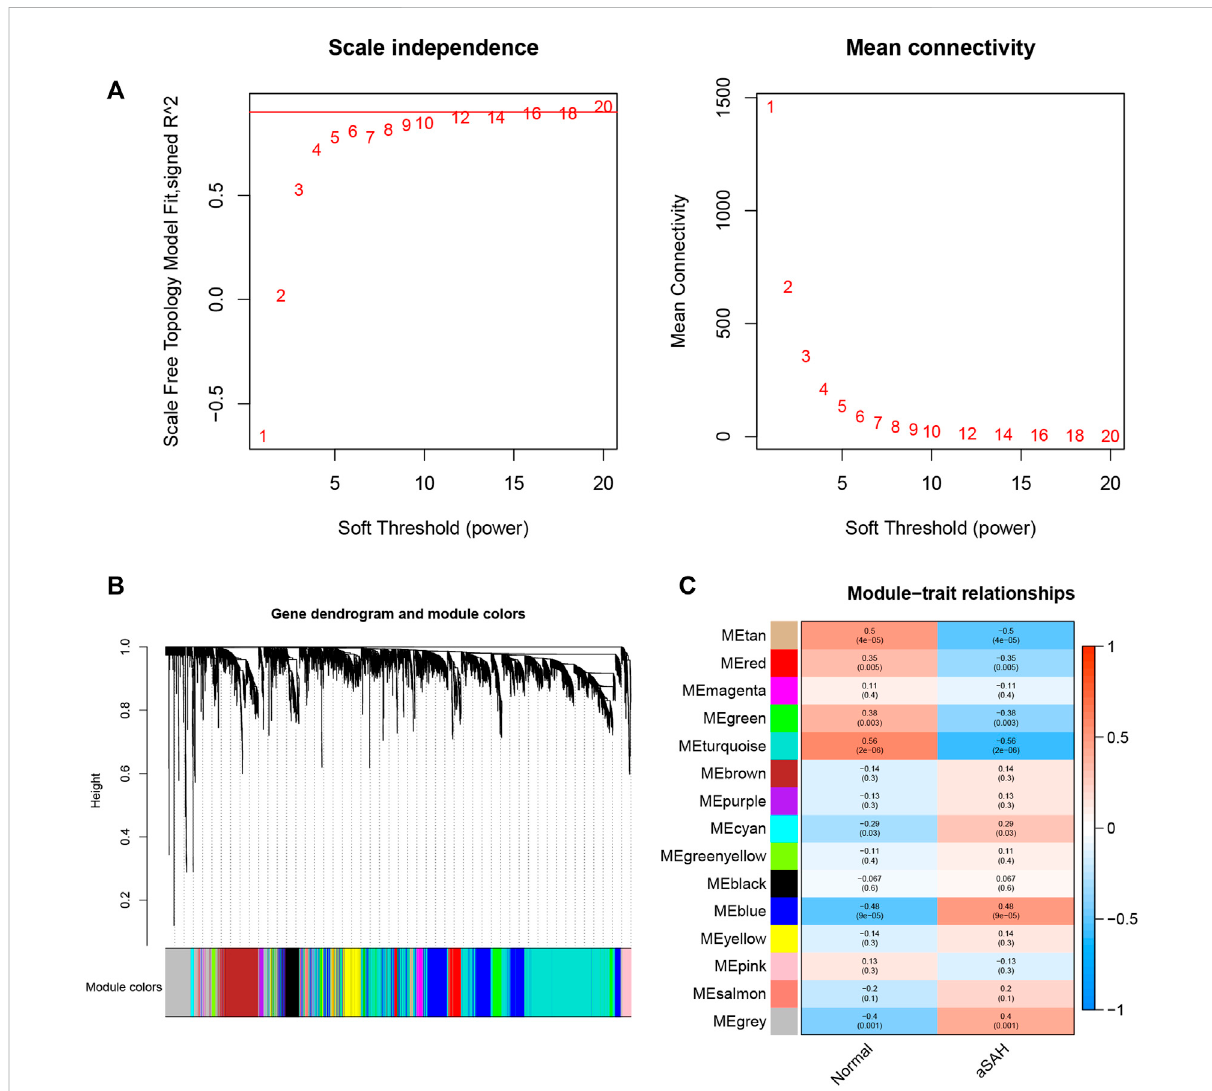
FIGURE 2 WGCNA revealed gene co-expression networks in the whole peripheral blood of aSAH patients. (A) Determination of soft-thresholding power. The red line indicates where the correlation coef fi cient is 0.9, and the corresponding soft-thresholding power is 12. (B) .Hierarchical cluster tree showing fi fteen modules of co-expressed genes identi fi ed by WGCNA. Each branch in the fi gure represents one gene, and every color below represents one co-expression module. (C) Relationships of consensus modules with